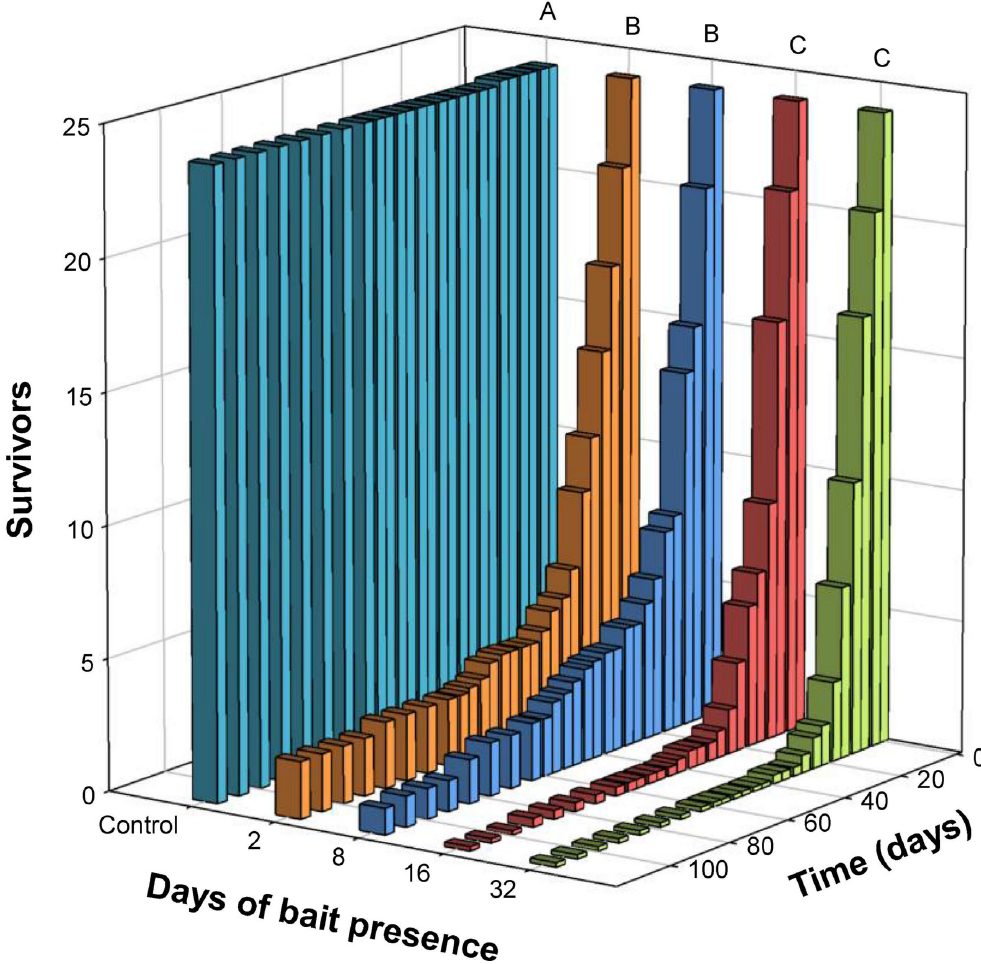
Fig 4. Different bait placement duration and survival of Ctenolepisma longicaudatum in population boxes. Different letters (A, B and C) indicate significant differences in survival between pairs of treatments (Kaplan–Meier survival analyses, p <